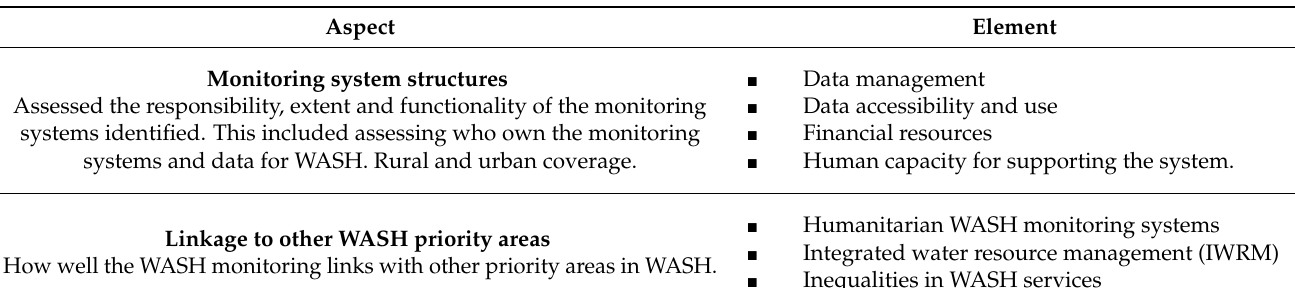
Table 1. Cont. Aspect Element Monitoring system structures Assessed the responsibility, extent and functionality of the monitoring systems identified. This included assessing who own the monitoring systems and data for WASH. Rural and urban coverage. Human capacity for supporting the system. Linkage to other WASH priority areas